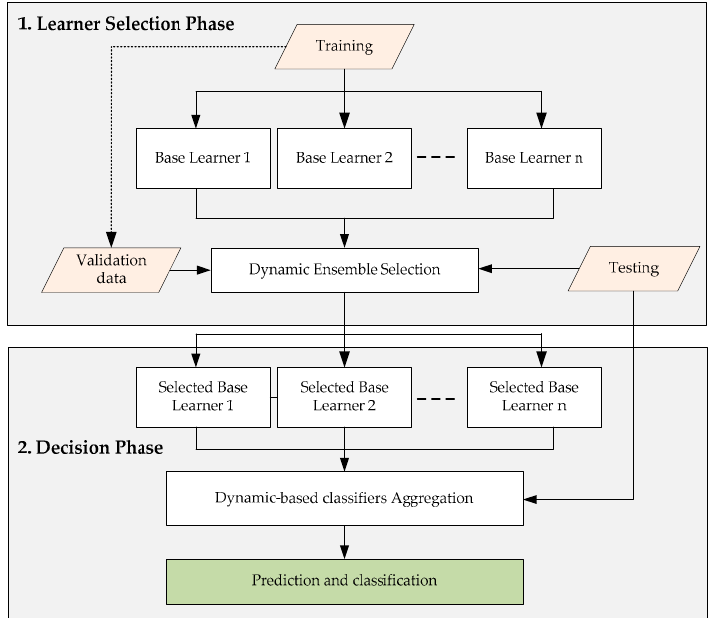
Figure 5. Dynamic Ensemble Selection